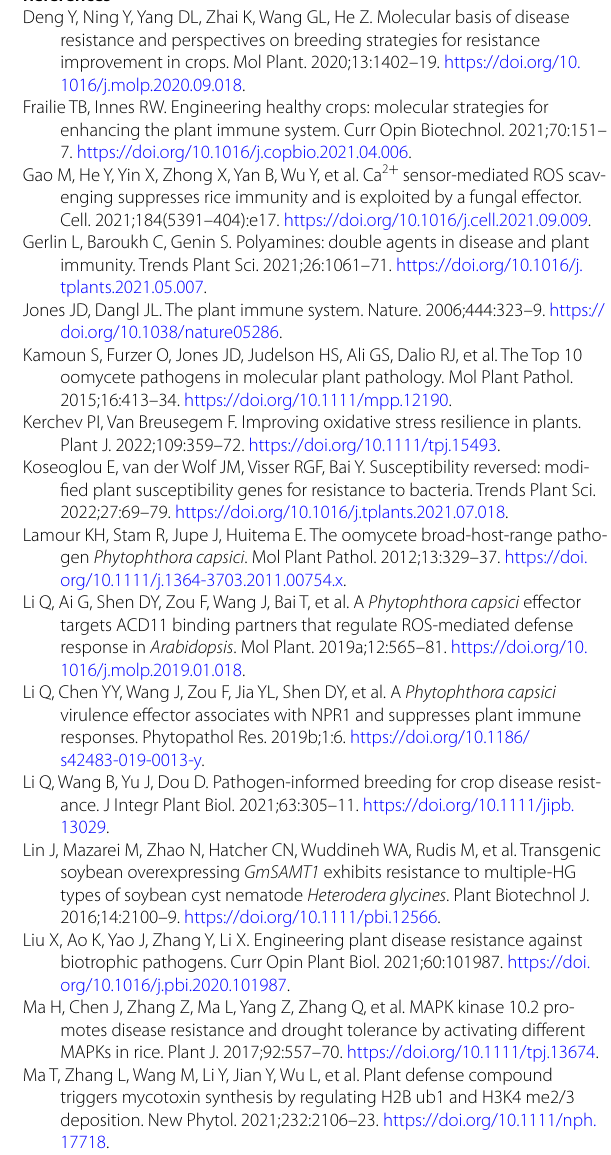
Additional file 2: Table S1. Statistical table of material identification for transgenic soybean lines. Table S2. Primers used in this study. Acknowledgements Not